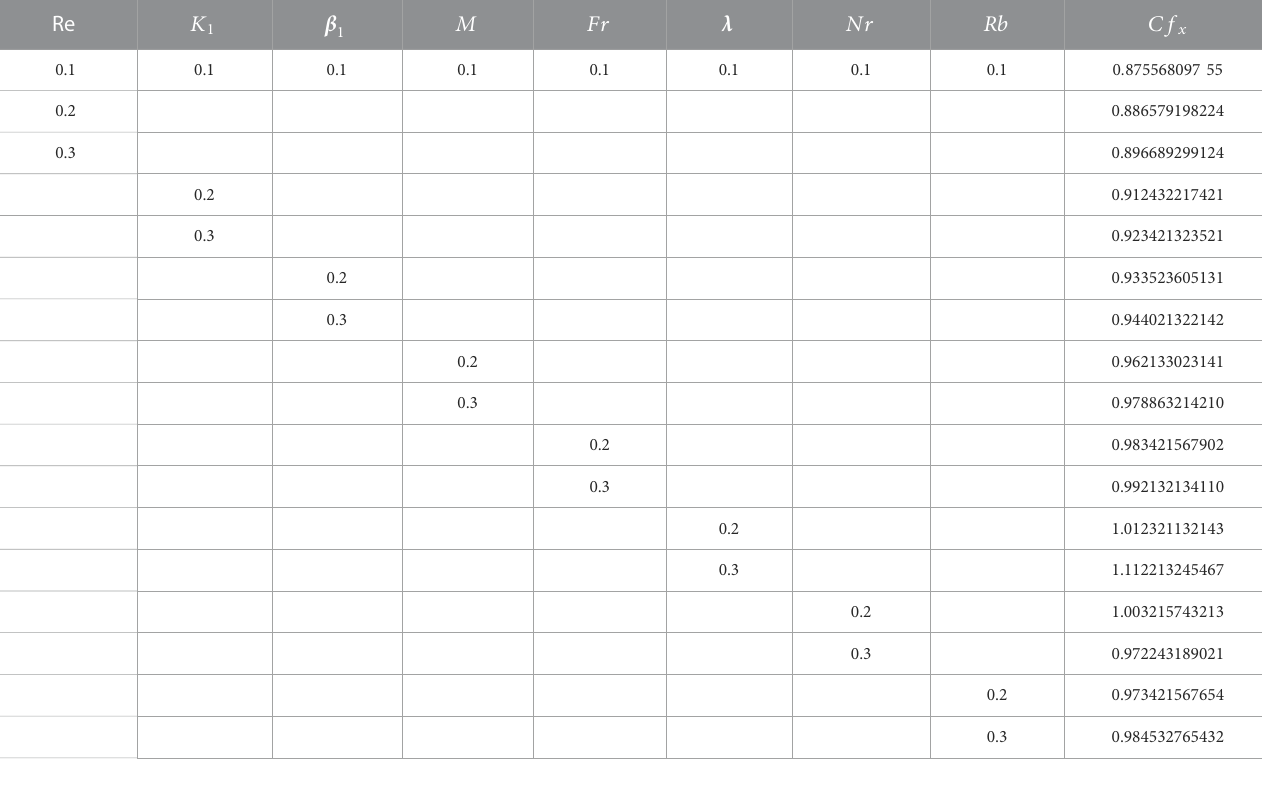
TABLE 2 Skin friction C fx Re x 0 . 5 vs. various parameters for the Maxwell nano fl uid.